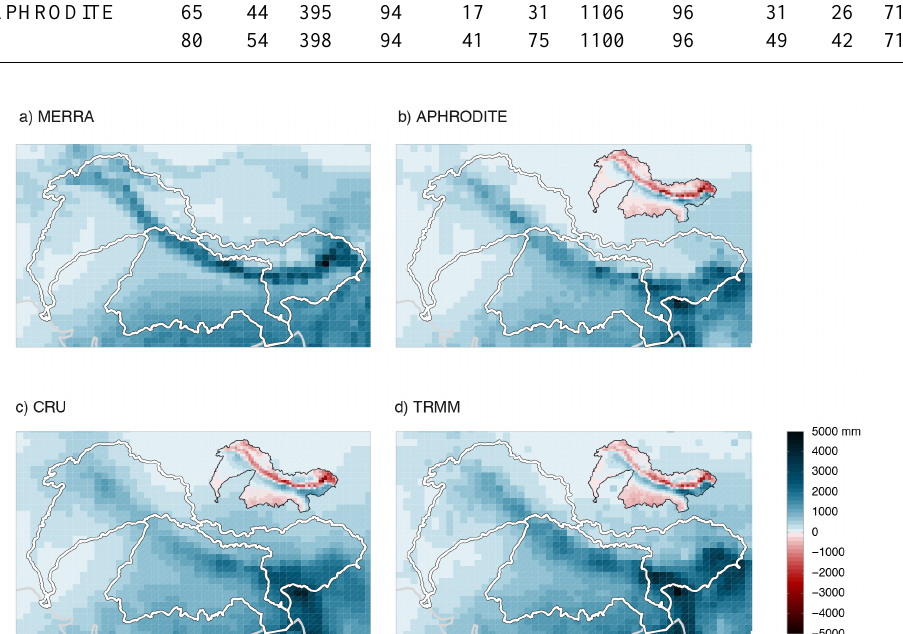
Figure 5. Difference between MERRA precipitation and observation-based data. (a) Annual mean MERRA precipitation. (b, c, d) Annual mean MERRA precipitation bias corrected with observations: APHRODITE, CRU TS and TRMM 3B42. For each data set, the small inset maps show the observations minus